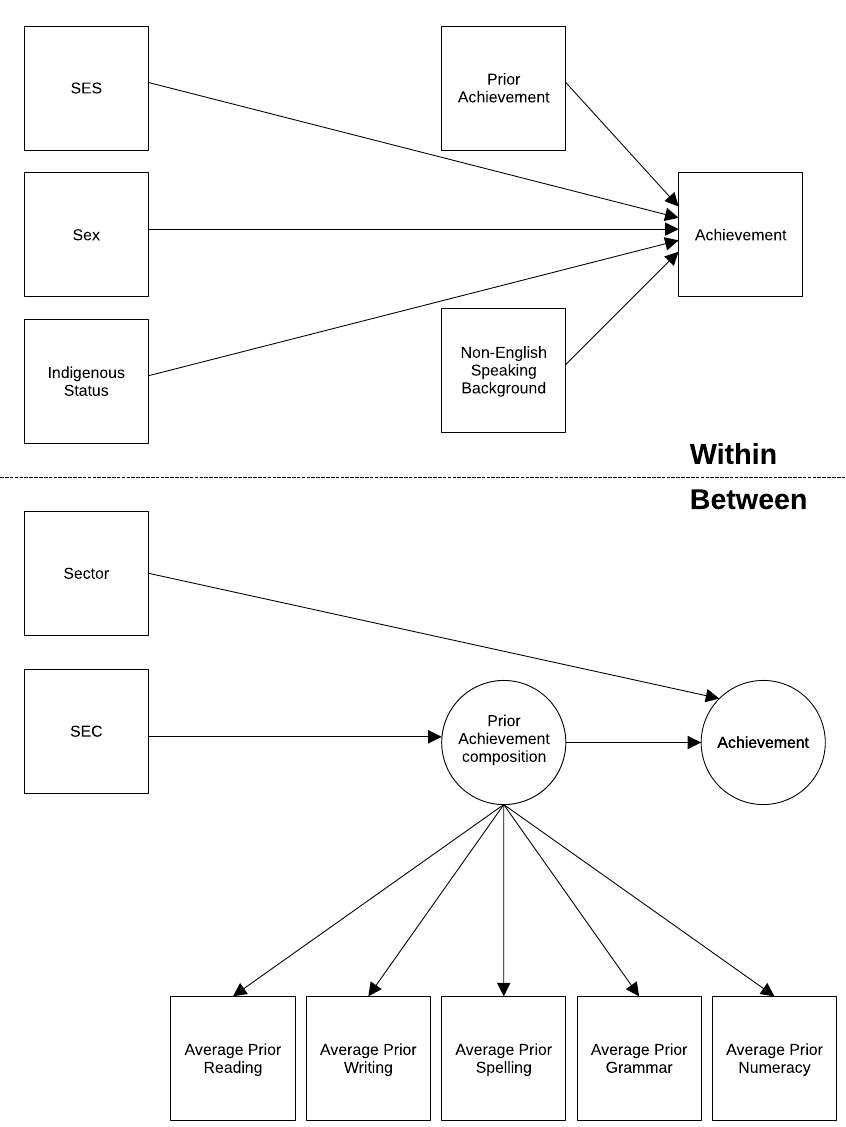
Fig. 1 Multilevel path model of SEC mediated by academic